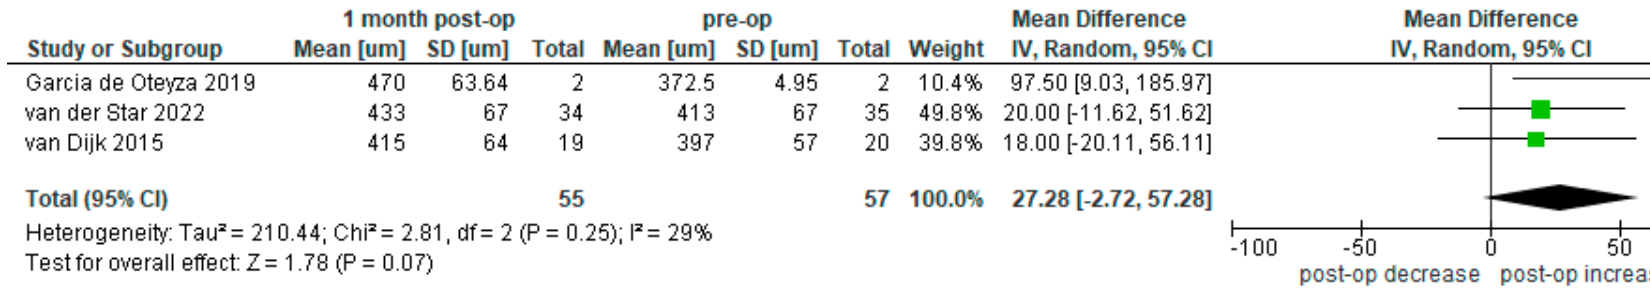
Figure A4. Di ff erence in pachymetry central point across 3 studies [28,31,43].